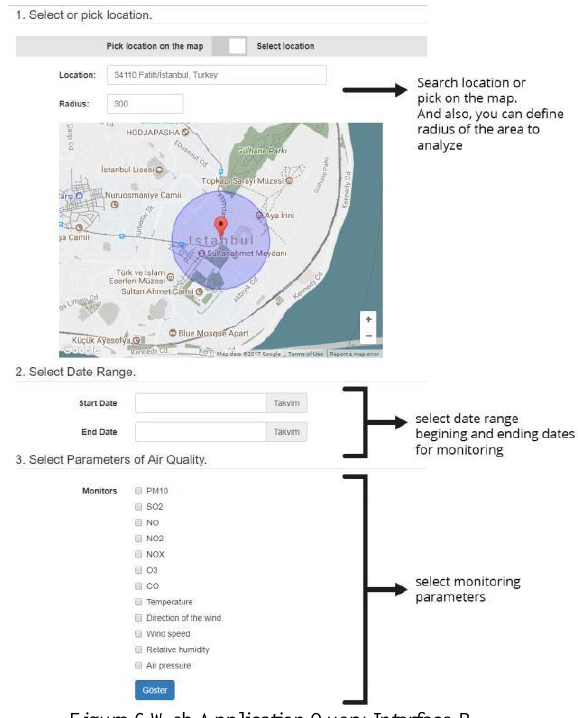
Figure 6.Web Application Query Interface-B